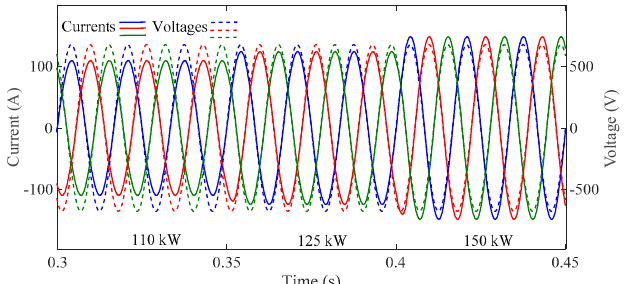
Figure 17. Currents ( i AB , i BC , i CA ) and voltages ( v AB , v BC , v CA ) for − 10% of tolerance in passive devices and an increase in parasitic resistances.